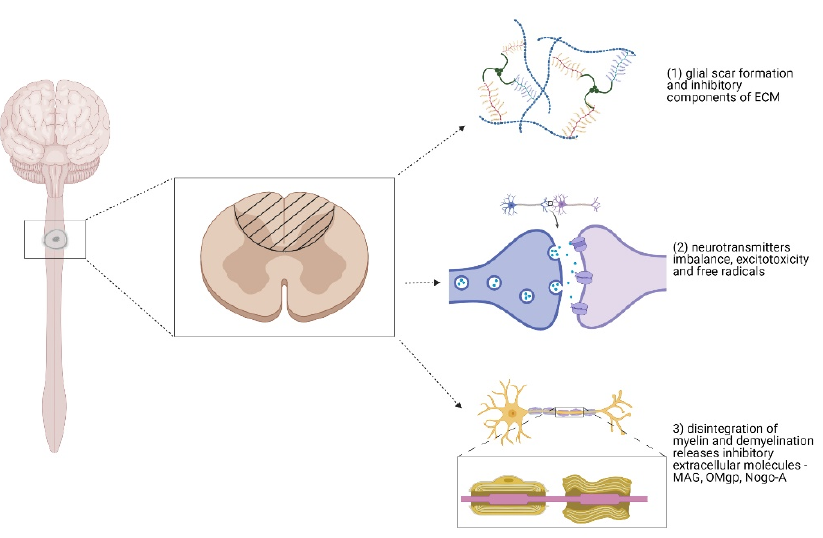
Figure 1. Spinal cord injury pathology. The regeneration following traumatic spinal cord injury (SCI) fails especially due to: ( 1 ) glial scar formation and changed extracellular matrix (ECM) environment caused by secretion of tenascin, chondroitin sulfate proteoglycans (CSPGs) such as brevican, phosphacan, neurocan, versican, and NG2 proteoglycans. All of these molecules lead to the activation of Rho-ROCK signaling pathway inhibiting regeneration; ( 2 ) Neurotransmitter imbalance, excitotoxicity, and free radicals release caused by overstimulation of cells; ( 3 ) inhibitory molecules associated with the ECM and those associated with myelin such as MAG, OMgp, Nogo-A released after myelin disintegration (Created with